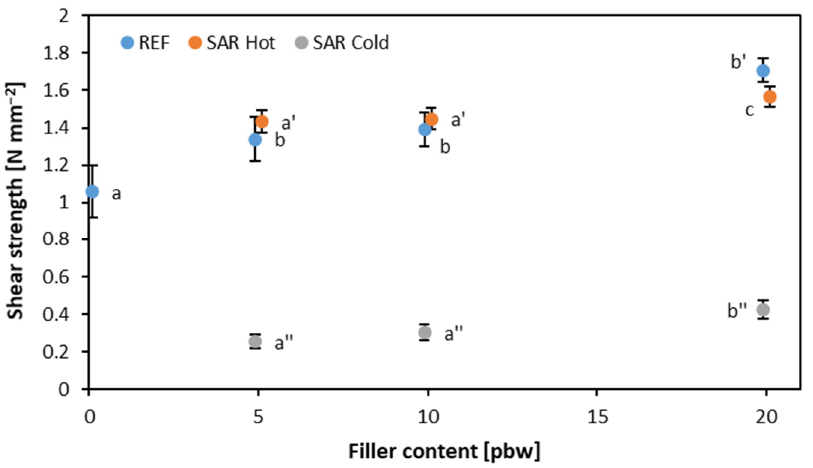
Figure 3. The shear strength of the plywood samples of different filler content (the letters on the plots indicate the homogeneous groups).